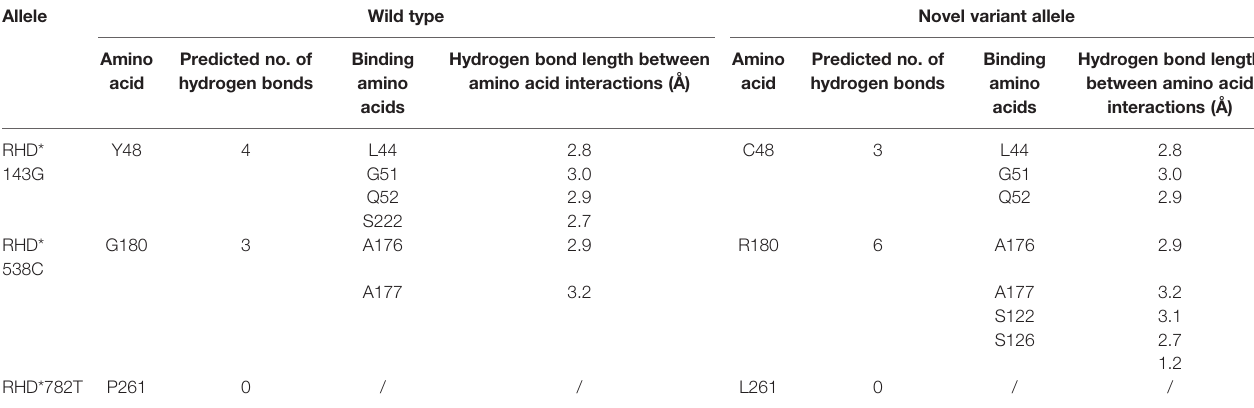
TABLE 3 | The parameter changes analysis of the substituted amino acids caused by the non-synonymous mutation in protein 3D structure.